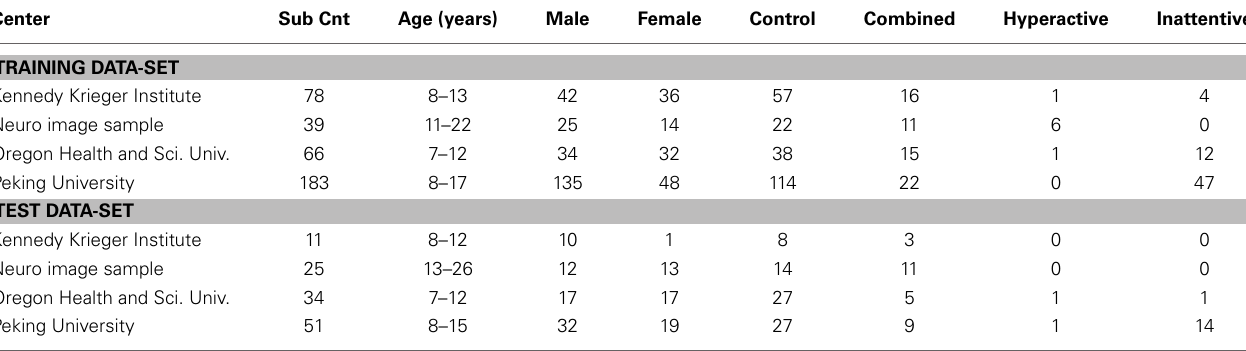
Table 1 | Summary of the training and test data-sets from four test centers which are used in our work. Center Sub Cnt Age (years) Male Female Control Combined Hyperactive